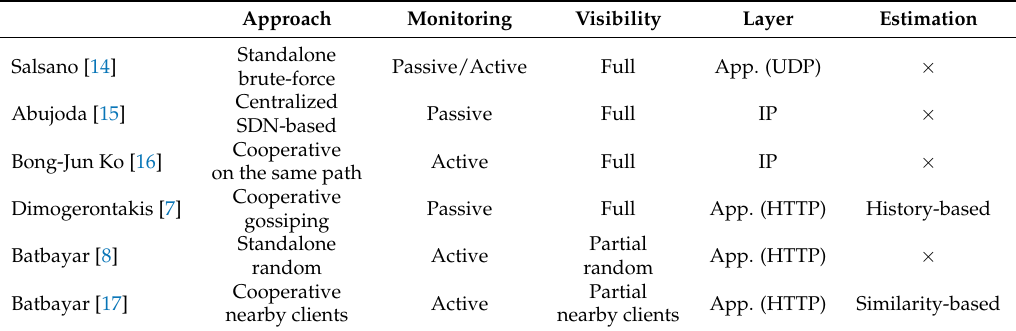
Table 1. Monitoring approaches for proxy